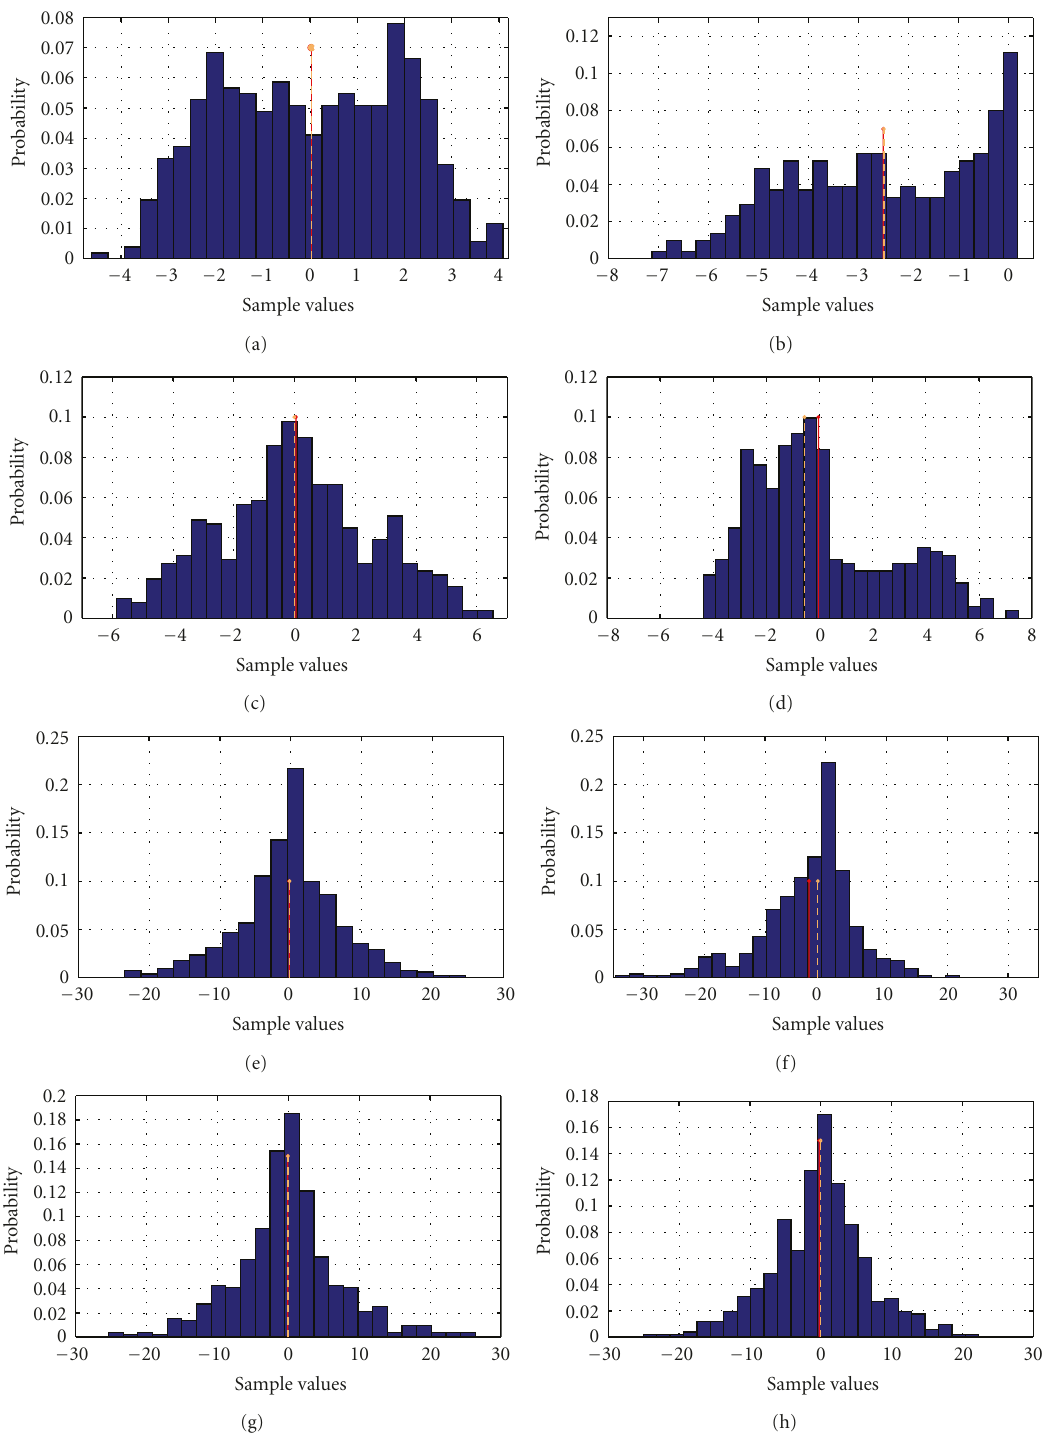
Figure 5: Histograms of R ( p , n ) (left column) and I ( p , n ) (right column) for: f p = F , σ G = 1; PCK RE = 0 . 330, MAD RE = 1 . 65, PCK IM = 0 . 341, MAD IM = 1 . 73 ((a) and (b)); f p = 3 F , σ G = 1; PCK RE = 0 . 243, MAD RE = 1.67, PCK IM = 0 . 252, MAD IM = 1 . 68 ((c) and (d)); f p = F , σ G = 10; PCK RE = 0 . 209, MAD RE = 3 . 77, PCK IM = 0 . 231, MAD IM = 3 . 94 ((e) and (f)); f p = 3 F , σ G = 10; PCK RE = 0 . 186, MAD RE = 3 . 46, PCK IM = 0 . 237, MAD IM = 3 . 92 ((g) and